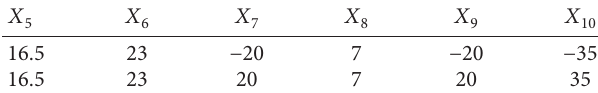
Table 10: Model-free checks with edge plan in Table 9.